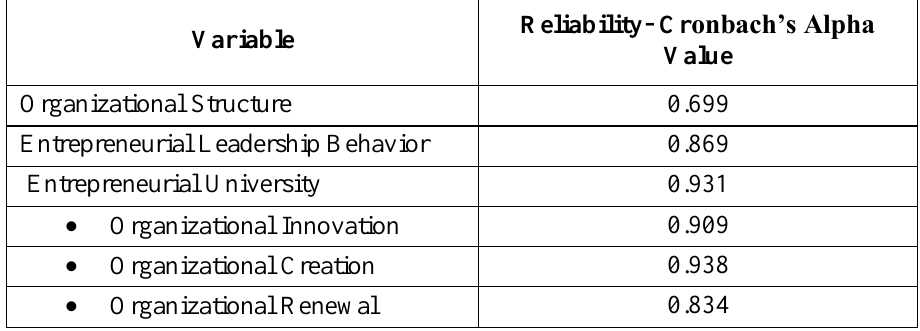
Table 02: Internal Reliability Score of the Scales Based on the Pilot